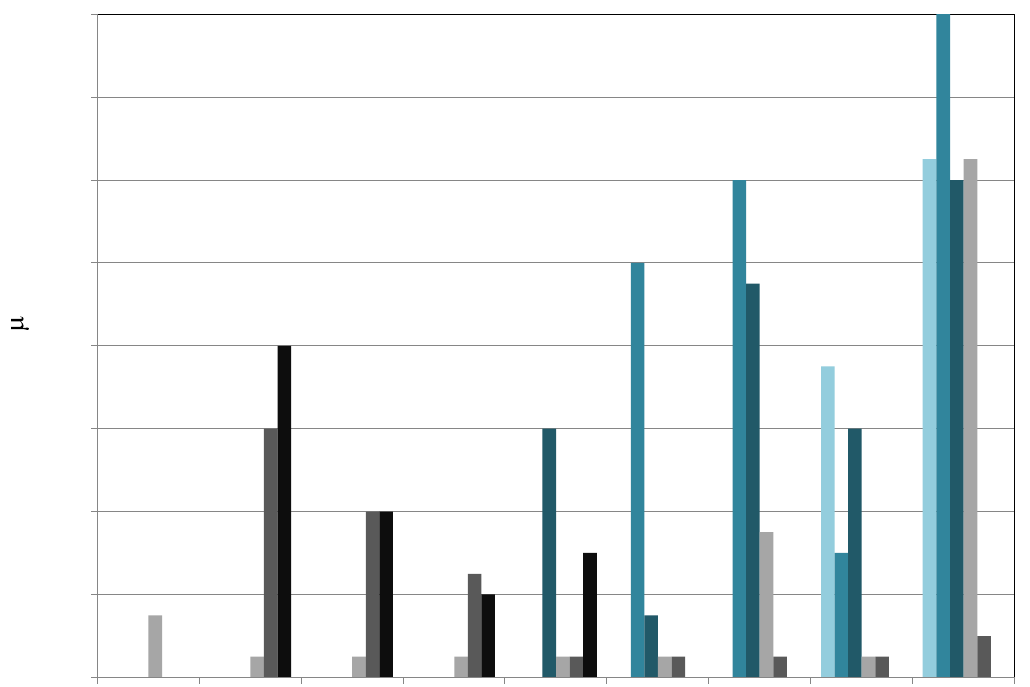
Figure 6. Di ff erential heat of NH 3 adsorption on yZrOx / S and VOx / yZrOx / S samples: Figure 6. Differential heat of NH 3 adsorption on yZrOx/S and VOx/yZrOx/S samples: Figure 6. Differential heat of NH 3 adsorption on yZrOx/S and VOx/yZrOx/S samples: Figure 6. Differential heat of NH 3 adsorption on yZrOx/S and VOx/yZrOx/S samples: Figure 6. Differential heat of NH 3 adsorption on yZrOx/S and VOx/yZrOx/S samples: Figure 6. Differential heat of NH 3 adsorption on yZrOx/S and VOx/yZrOx/S Figure 6. Differential heat of NH 3 adsorption on yZrOx/S and VOx/yZrOx/S samples: Figure 6. Differential heat of NH 3 adsorption on yZrOx/S and VOx/yZrOx/S samples: